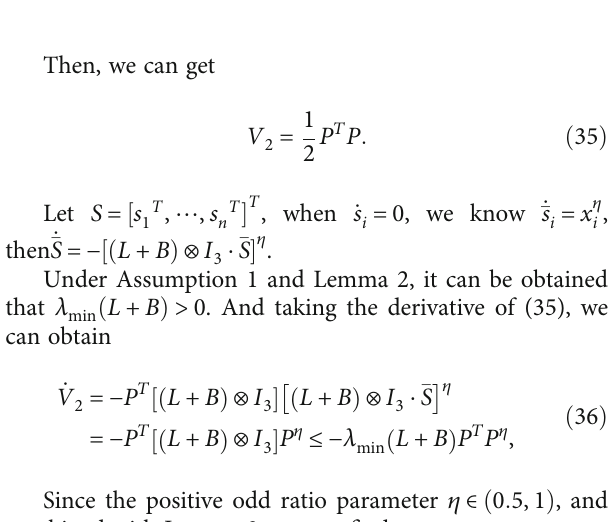
Figure 2: Communication